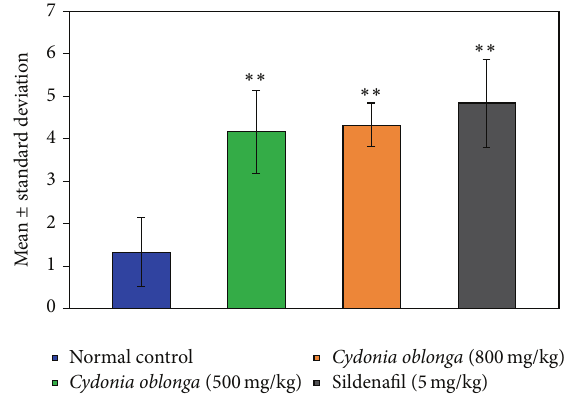
Figure 2: Effect of Cydonia oblonga on the mating performance of male rats on the 28th day of the